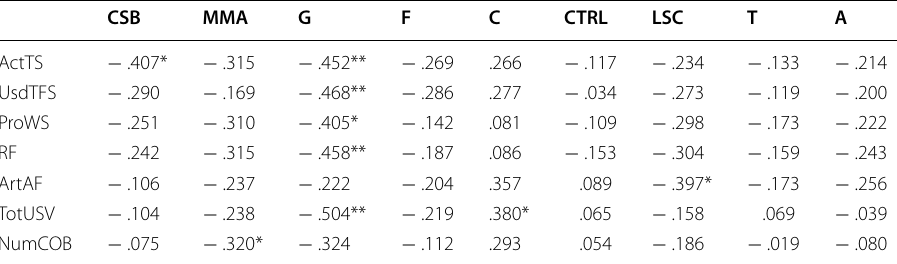
Table 1 Bivariate correlation coefficients (Kendall’s τ ) and significance between each data log and flow experience